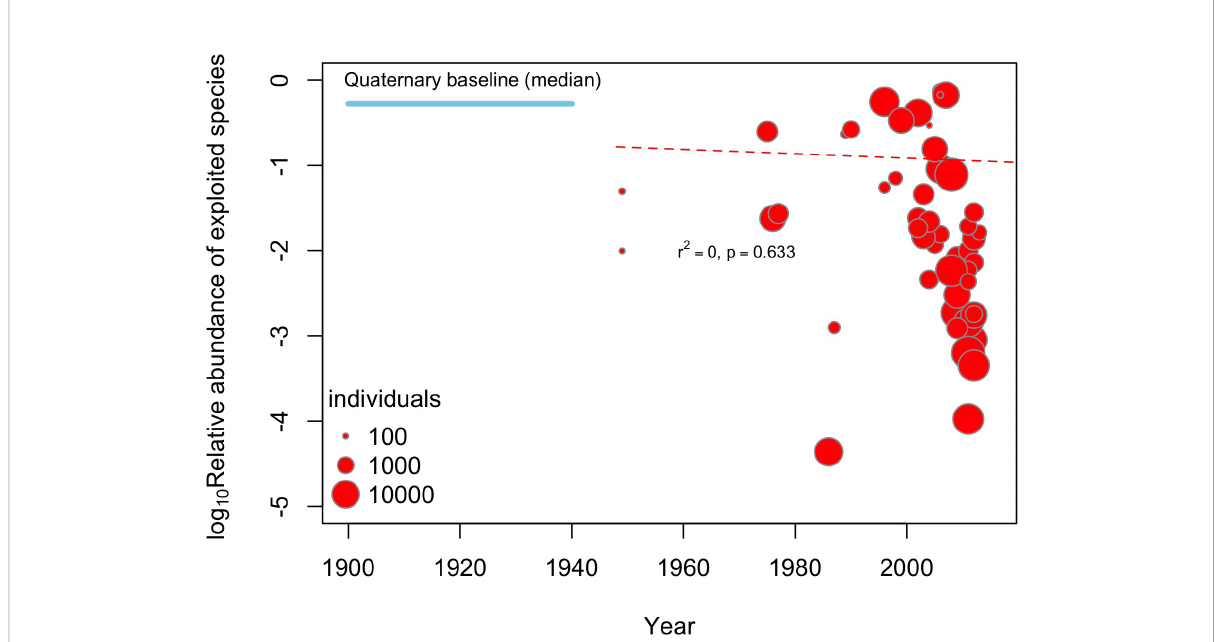
FIGURE 5 Meta-analysis testing the existence of temporal changes in the relative abundance (log 10 ) of exploited species during the last ca. 70 years at the HCE, aggregated a scale of 1° (~100 km). The size of circles is proportional to the sampling size. The dotted red line shows the meta-regression fi t line between the relative abundance and the sampling year (not signi fi cant). For comparison, the mean relative abundance of exploited species obtained for fossil assemblages at a similar spatial aggregation scale are